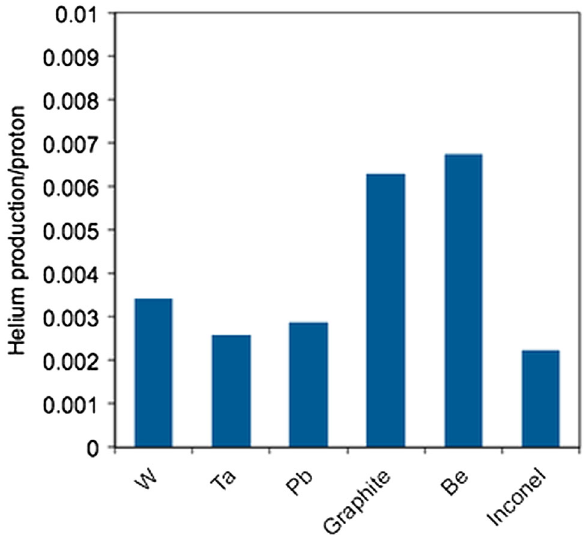
FIG. 6 (color online). Total helium production in different target